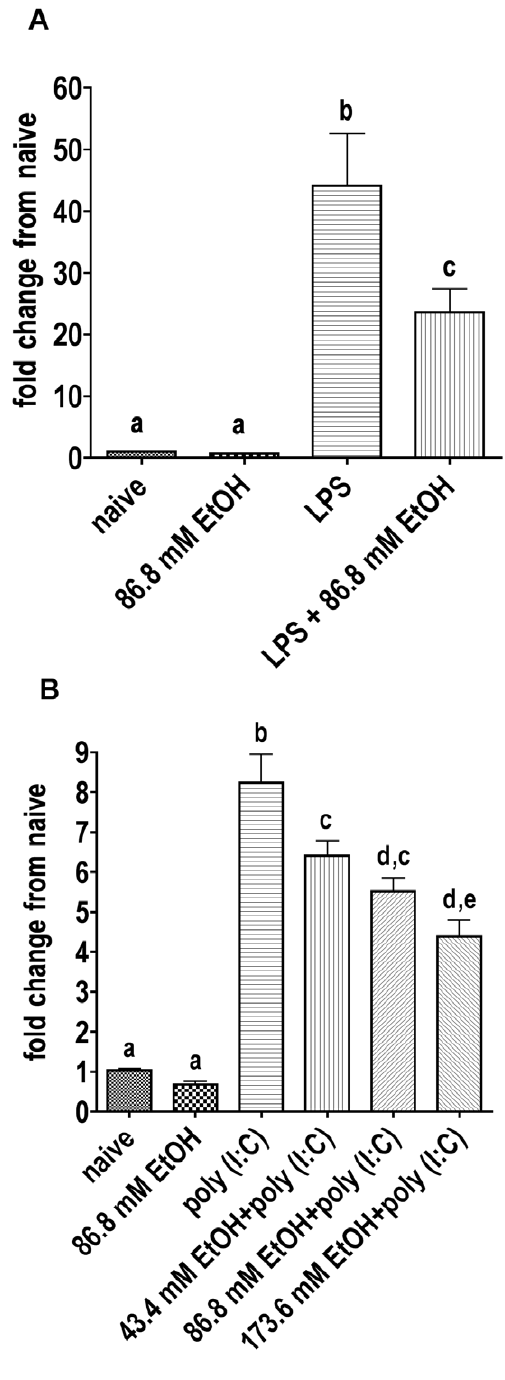
Figure 3. Real time RT-PCR with mRNA isolated from RAW264.7 cells treated with ethanol and LPS or poly I:C. Naive groups received no treatment. A Appropriate groups were treated with ethanol for 30 min, then with LPS for further two hours. The average of two experiments, each with three replicates, were pooled. Each sample replicate was doubled in the PCR plate. 86.8 mM ethanol significantly reduced the LPS induced TNF- a mRNA expression (P , 0.001). Treatment with ethanol only was not significantly different from naive. B Appropriate groups were treated with different concentrations of ethanol for 30 min, then with poly I:C for further two hours. The average of two experiments, one with three replicates, and one with two replicates, is shown. Each sample replicate was doubled in the PCR plate. A concentration of 43.4 mM EtOH and higher significantly reduced the poly I:C induced TNF- a mRNA expression (P , 0.01). Ethanol